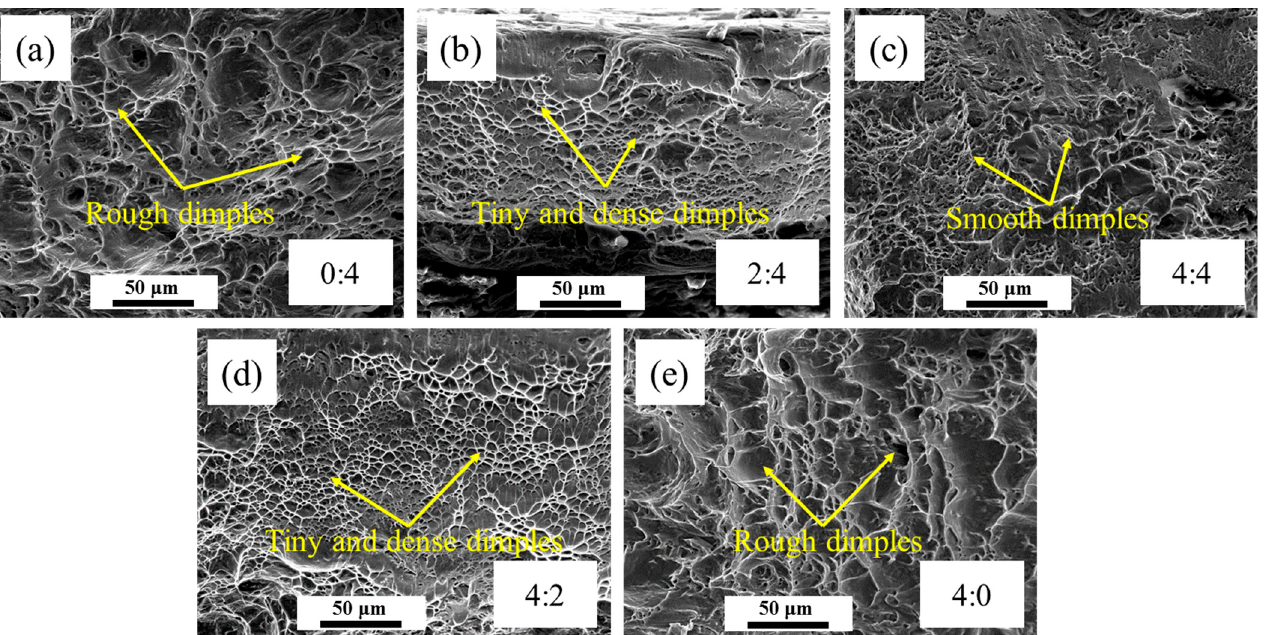
Figure 9. Fractographs of tensile failed specimens under various load ratios: ( a ) 0:4, ( b ) 2:4, ( c ) 4:4, ( d ) 4:2, ( e ) 4:0.